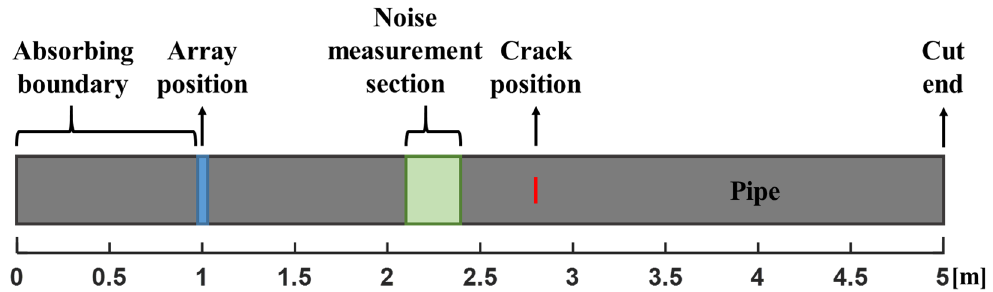
Figure 6. FE pipe model